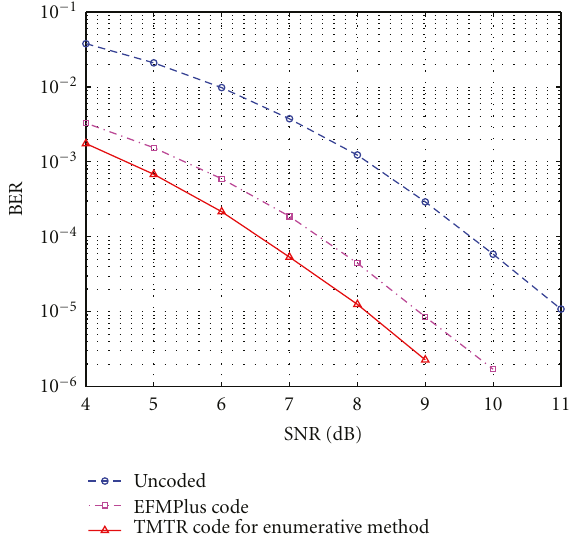
Figure 8: Error performance of TMTR-/EFMPlus-coded and uncoded EPRII systems.